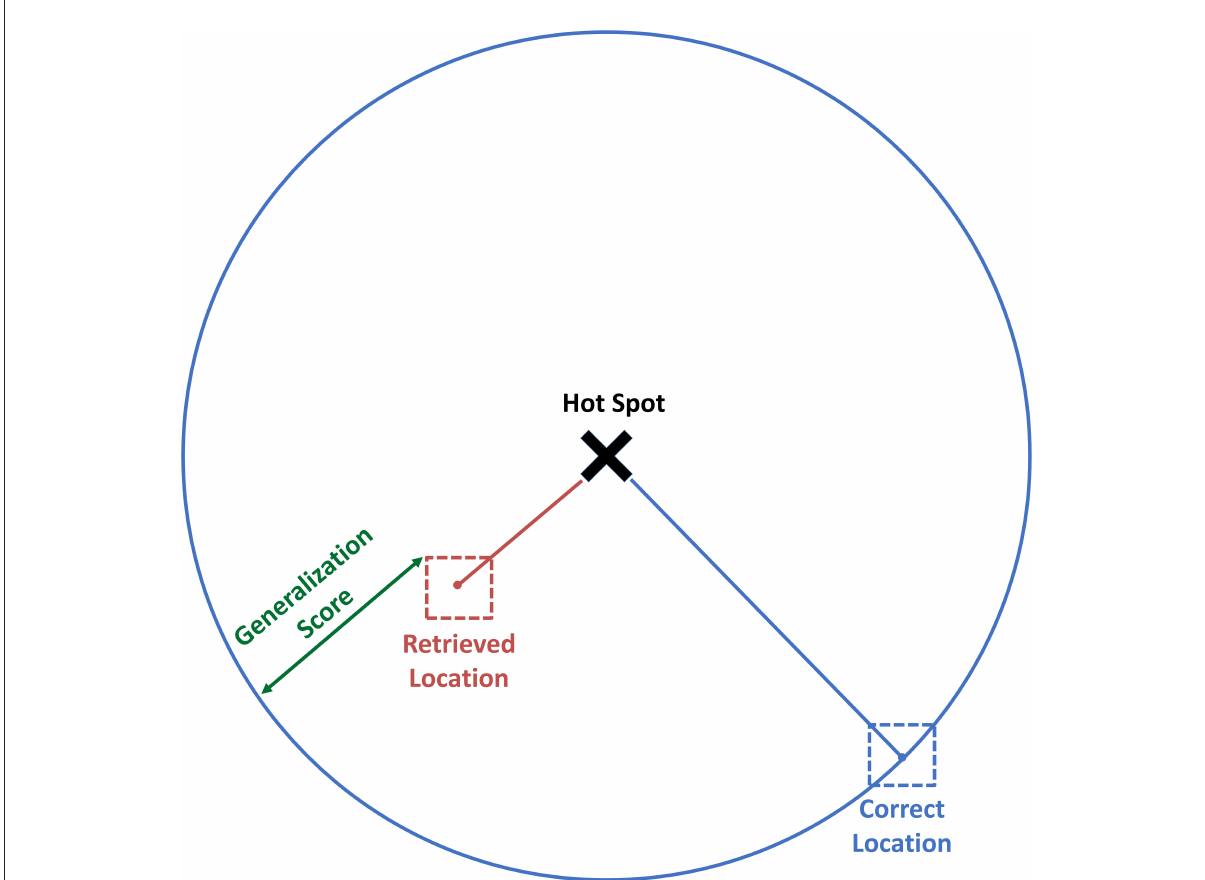
FIGURE3 Operationalisation of generalisation. Generalisation for a single retrieved face location, R, was calculated by subtracting the distance of this location to the hotspot location, RH, from the distance of the correct face location to the hotspot, CH. Distances RH and CH were calculated with the Pythagorean equation. C, Correct location; H, Hotspot; R, Retrieved